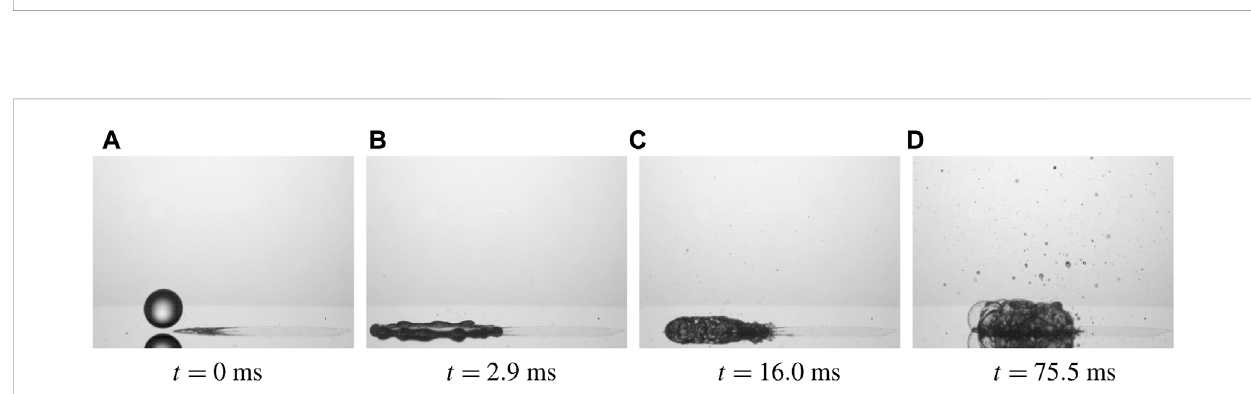
FIGURE 12 Twomajormechanismsleadingtoasigni fi cantchangeofthevalueofthepercolationtimeandthereforeoftheLeidenfrostpoint: (A) increaseofthe wettability of the substrate after evaporation of the previous lubricant drops in the impacting spray; (B) presence of the surfactants and salts in the lubricant solution prevent the bubbles ’ coalescence by formation a stable separating fi lm between bubbles. This phenomenon not only increases the value of the percolation time, but also leads to the formation of a foam.